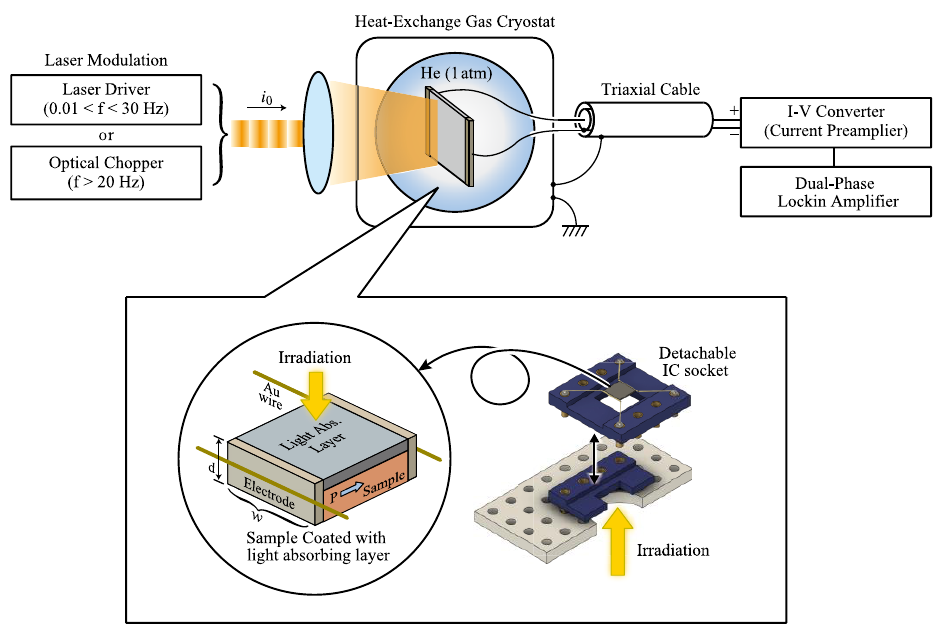
Figure 1. The setup of the temperature-modulated measurement of pyroelectricity. The standard sample with in-plane electric polarization is coated with a light-absorbing layer on the front surface. A pair of conductive-paste electrodes are attached to the crystal edges to collect the pyroelectric signal. The sample suspended upside down in the IC socket by the gold leads is irradiated through the hole in the sample holder and the base plate.